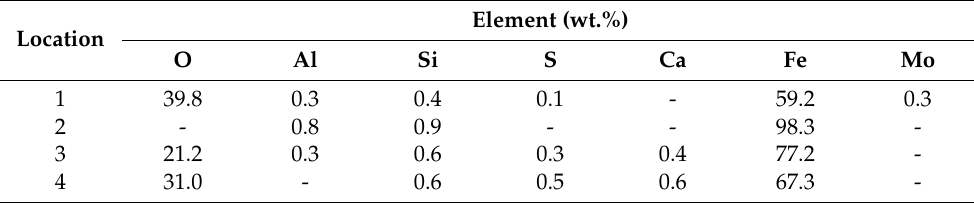
Table 7. Elemental analysis from locations in Figure 6.